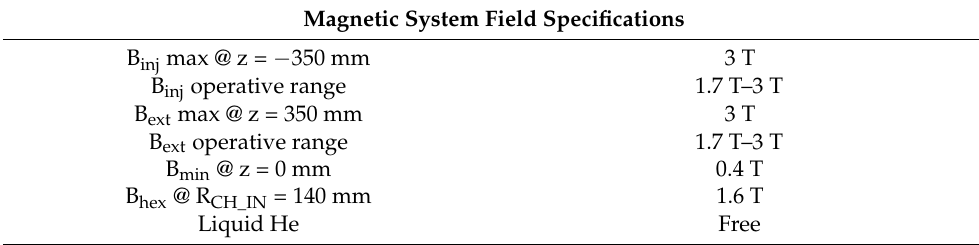
Table 1. PANDORA magnetic field